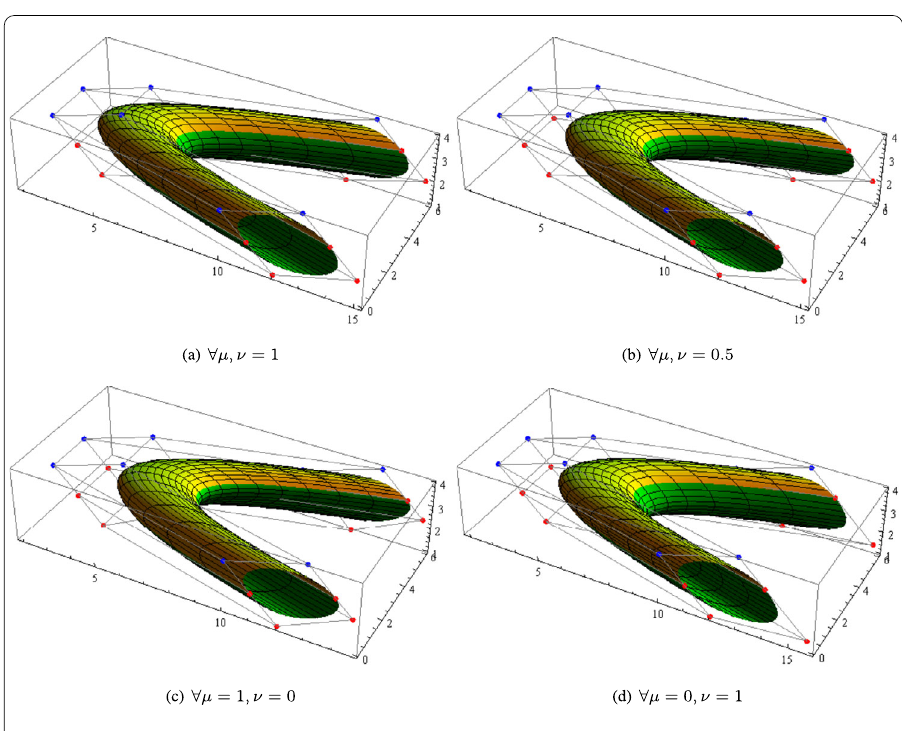
Figure 19 C 1 continuity of two contiguous GBT-Bézier swept surfaces